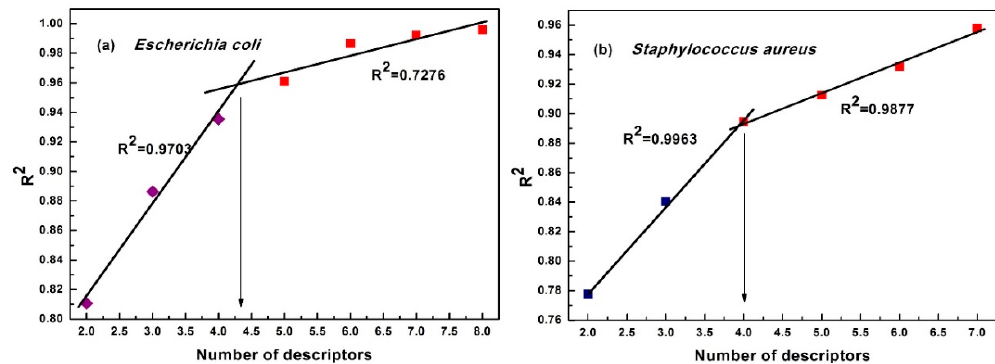
Figure 2. Breaking point rule for determination of the descriptor number. ( a ) is breaking point rule for model against E. coli , ( b ) is the breaking point rule for model against S. aureus .